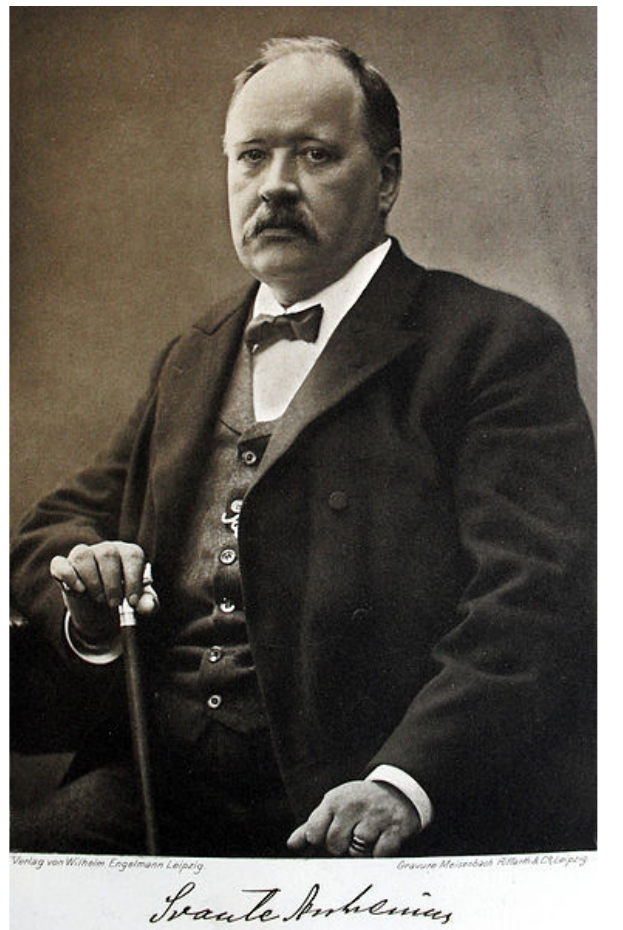
Figure 2. Arrhenius celebrated as a co-founder of physical chem- istry. Source: Zeitschrift für physikalische Chemie Vol. 69 (1909).